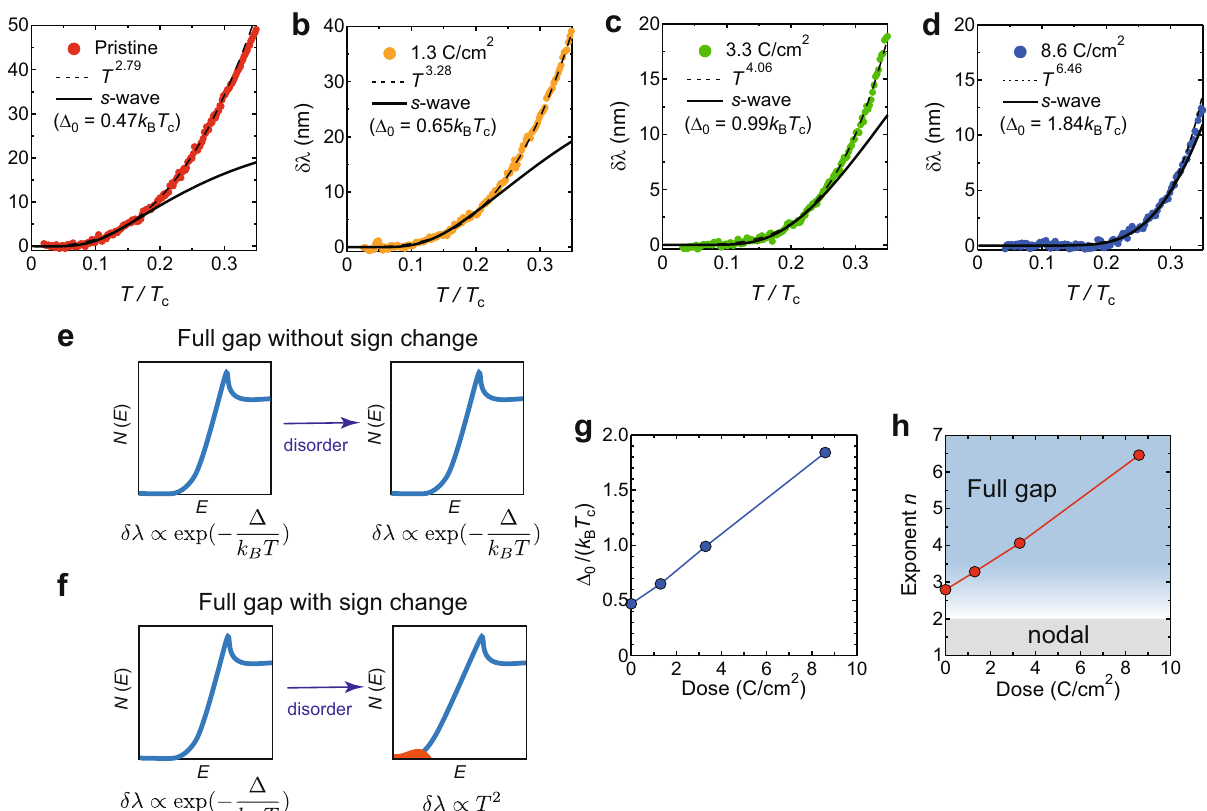
Fig. 2 | Electron irradiation effects on the low-temperature penetration depth. a – d Temperaturedependenceofthechangeinthepenetrationdepth δλ ( T )forthe pristine( a ),1.3( b ),3.3( c ),and8.6( d )C/cm 2 irradiatedsamples.Solidcirclesarethe experimental data. Black solid and dashed lines are fi tting curves of the fully gap- ped s -wave and power-law analysis. e , f Schematics of the change in the quasi- particle densityofstatesagainst disorderinthecaseof fullygapped stateswithout